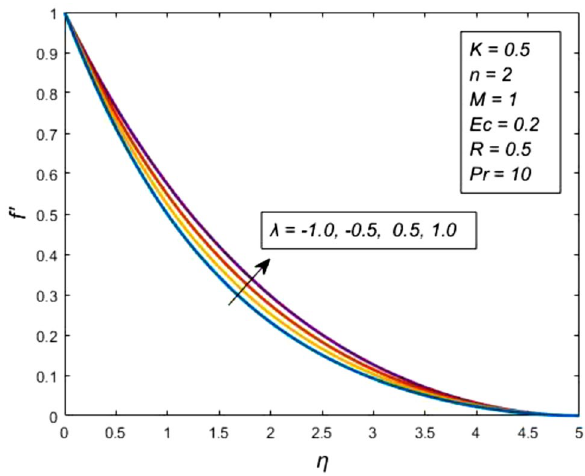
Figure 6. Impact of mixed convection parameter (cid:31) on the velocity profile.